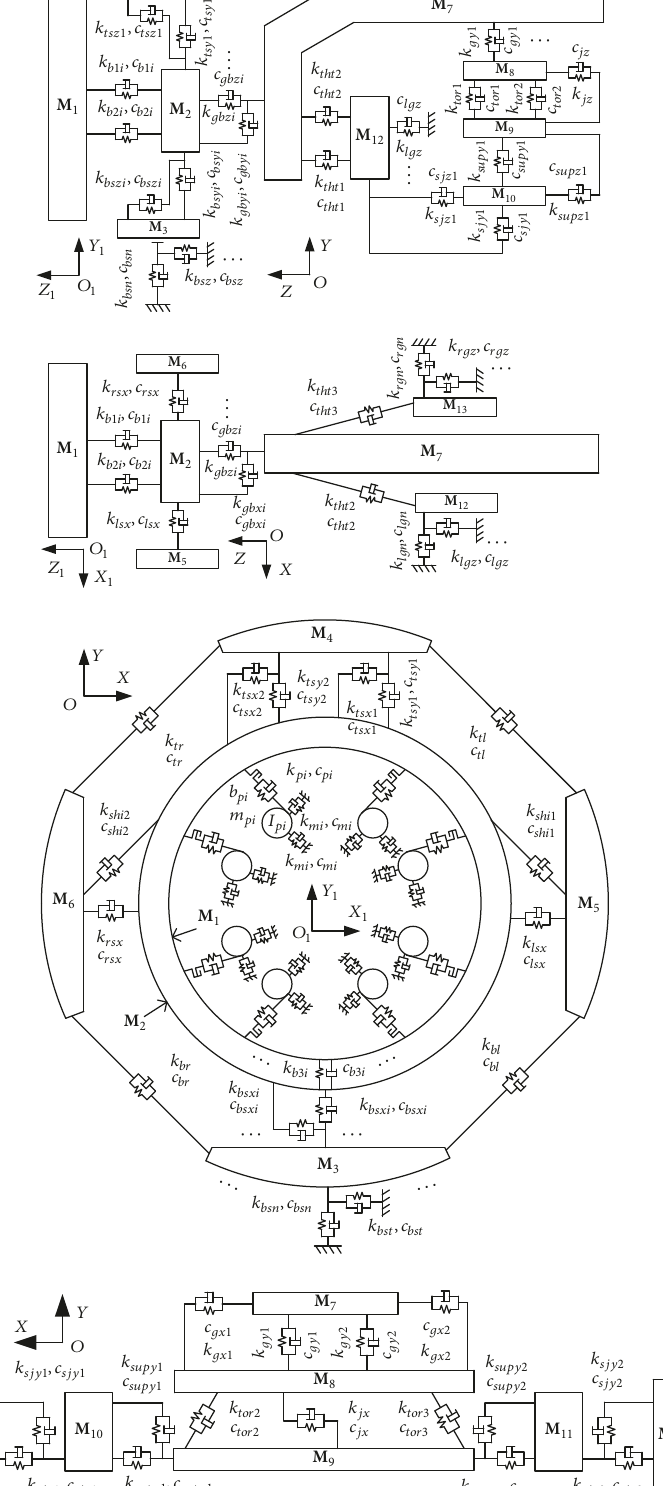
Figure 2: Dynamic model of an opening hard rock TBM. (1) Cutter head. (2) Gearbox. (3) Bottom shield. (4) Top shield. (5) Left shield. (6) Right shield. (7) Main beam assembly. (8) Saddle. (9) Support cylinder body. (10) Left cylinder rod. (11) Right cylinder rock. (12) Left shoe. (13) Right